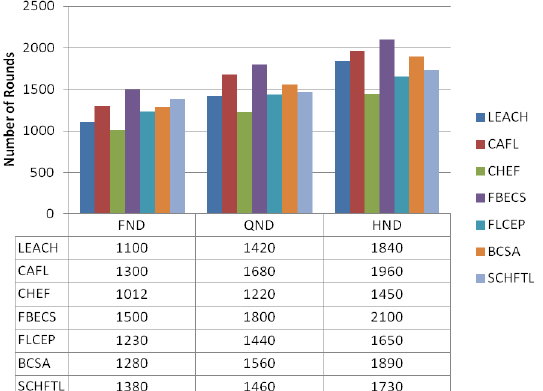
Figure 8. Common network scenario of WSN Table 3. Common Simulation Parameters